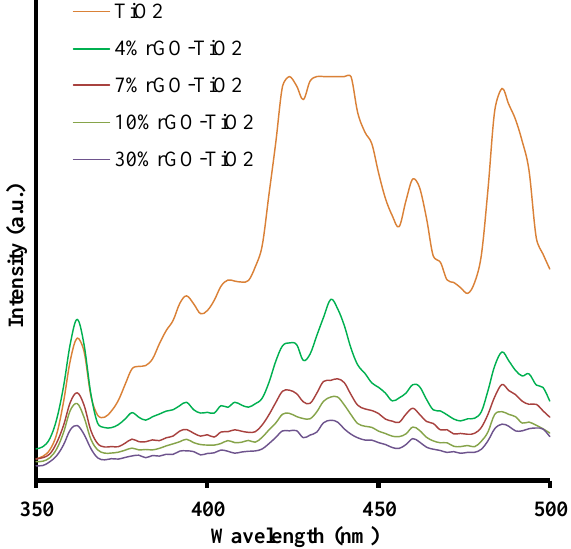
Figure 11. Photoluminescence spectra of TiO 2 and rGO-TiO 2 composites with different rGO percentages (excitation wavelength 264 nm).